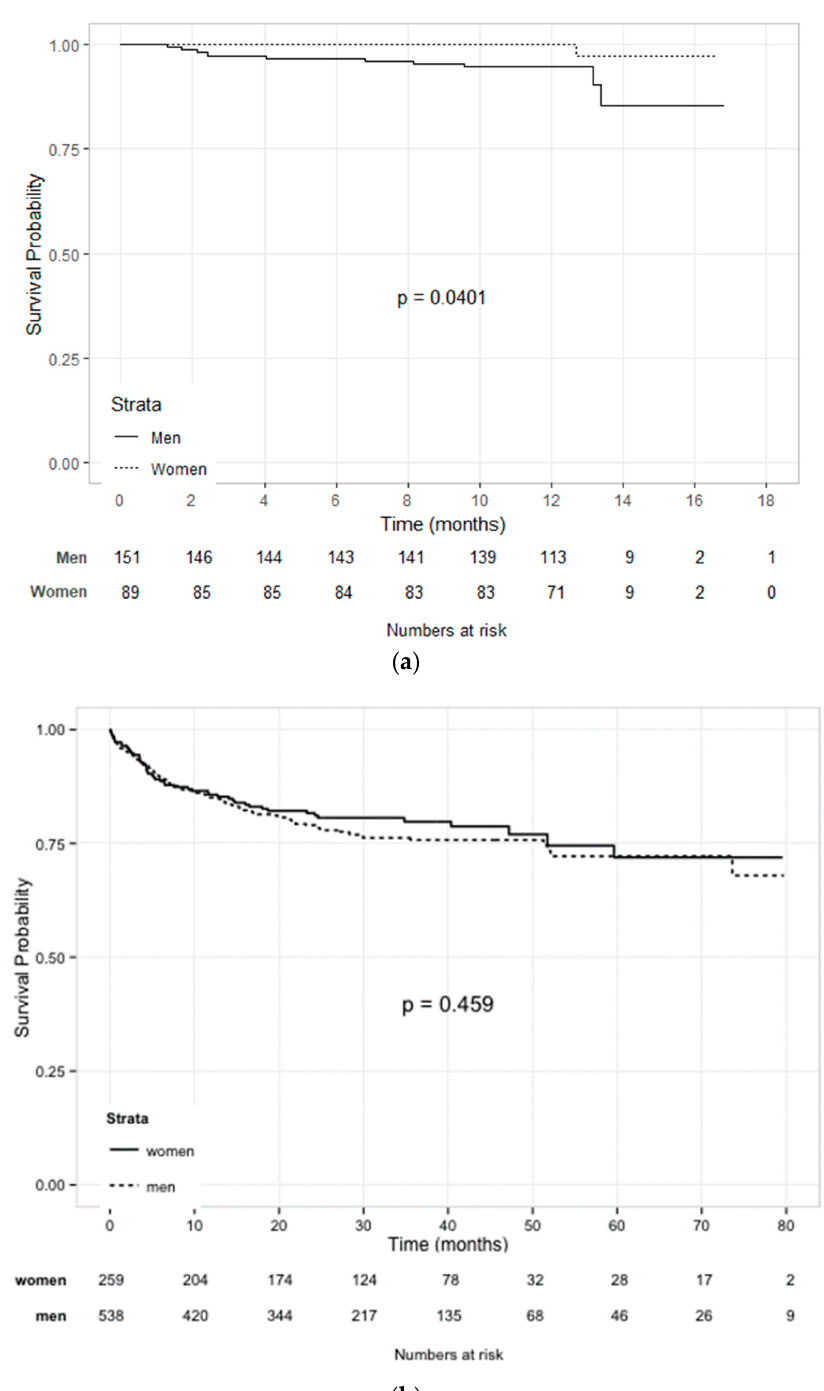
Figure 1. ( a ): Kaplan–Meier for all-cause mortality for groups based on sex in the MARC cohort; ( b ): Kaplan–Meier for mortality and heart failure hospitalization for groups based on sex in the Belgian